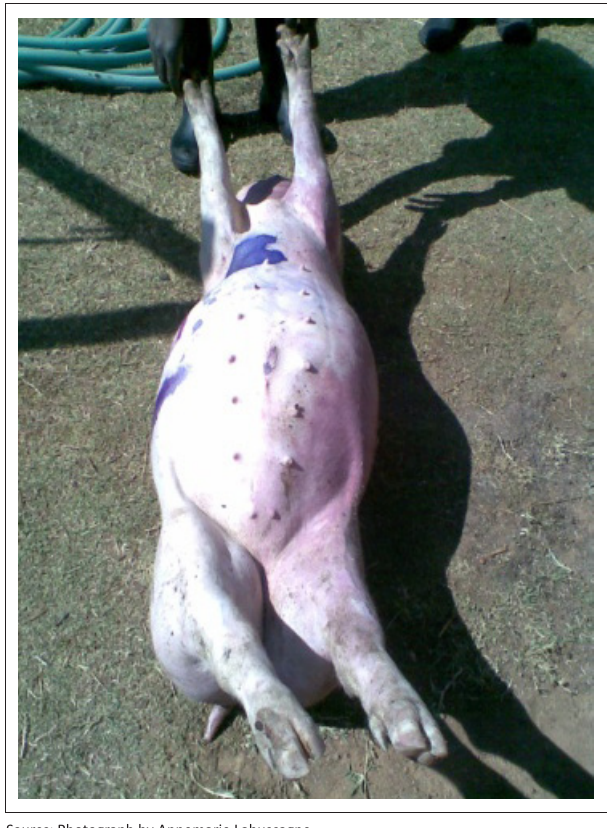
FIGURE 1: Carcass of pig with markedly distended abdomen.